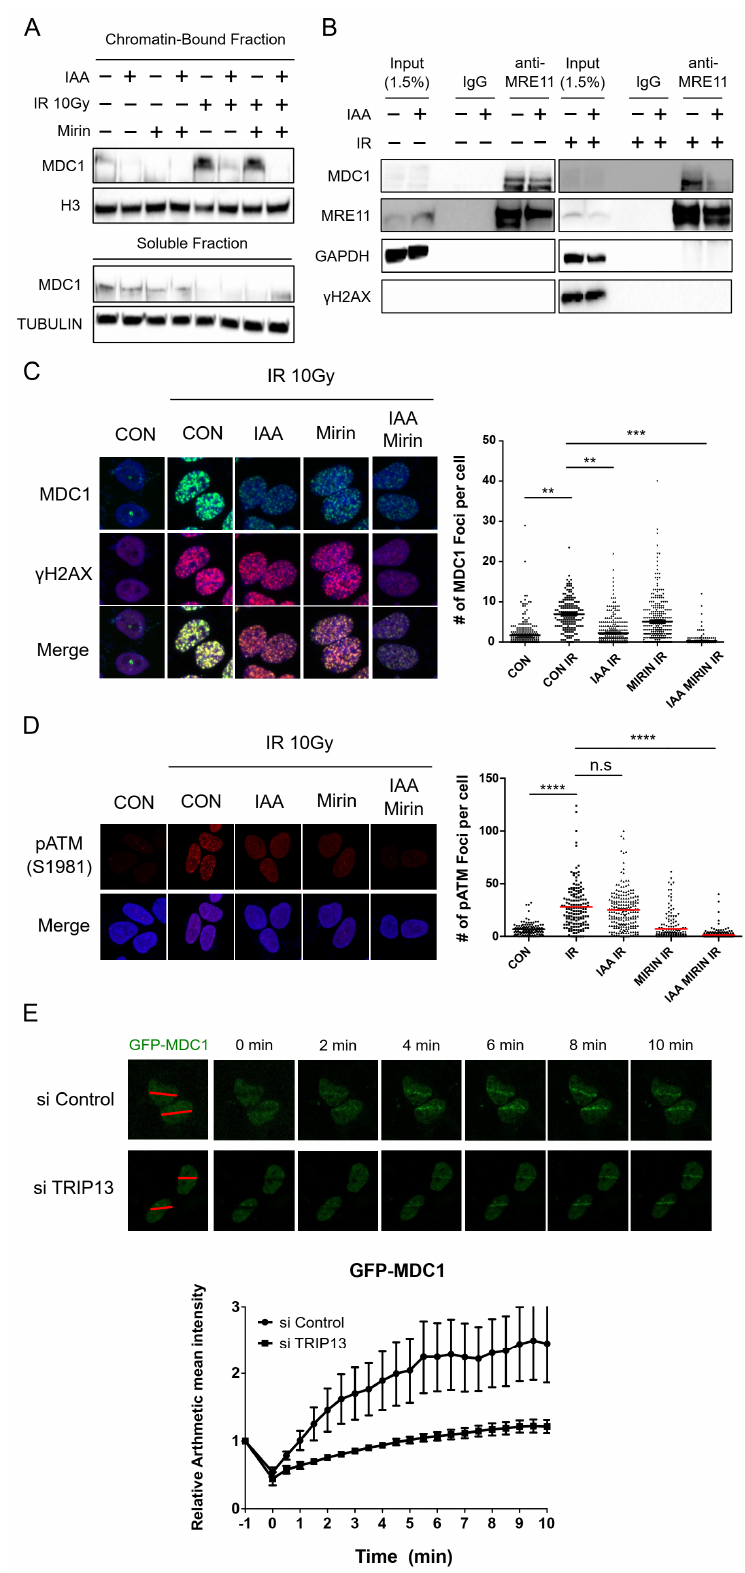
Figure 3. Depletion of TRIP13 inhibits MDC1 recruitment to DNA damage sites by decreasing the physical interaction between the MRN complex and MDC1. ( A ) The chromatin-bound fraction of MDC1 was decreased when TRIP13 was degraded by IAA treatment. We analyzed the cells after one-hour IR irradiation. We also confirmed that TRIP13 depletion did not alter the expression